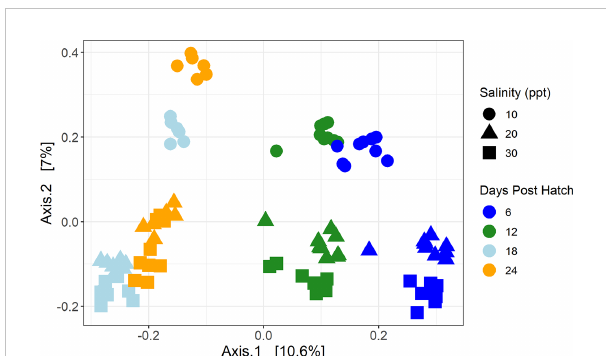
FIGURE 3 Principal coordinates of analysis of water samples using a Bray- Curtis dissimilarity matrix. Color represents days post hatch with dark blue representing samples taken 6 days post hatch, green 12 days post hatch, light blue 18 days post hatch, and orange 24 days post hatch. Shape represents salinity with circles representing samples that were at 10 ppt, triangles 20 ppt, and squares 30